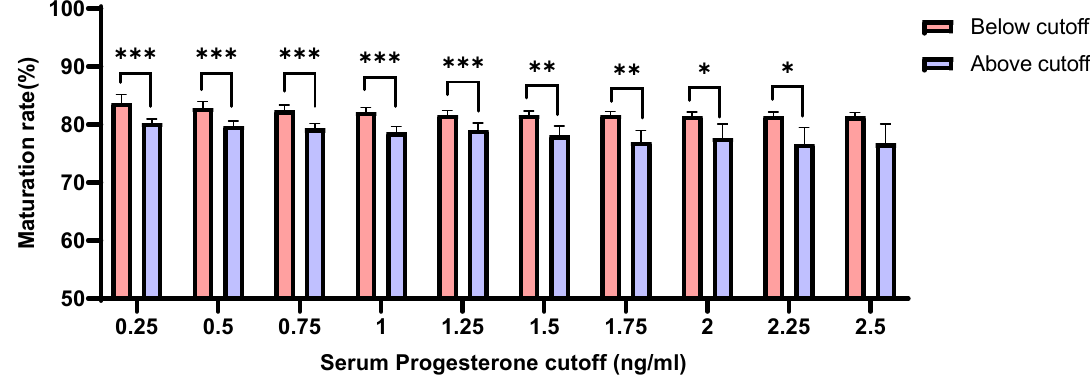
Figure 2. Association of the rates of oocyte maturation with the concentration of serum P4 levels (below or above each cut-off) on the day of hCG administration ( p < 0.05(*), p < 0.01(**), p < 0.001(***)). 3.4. The Effect of Serum Progesterone Levels on the Rate of Fertilization We evaluated the correlation between the levels of serum P4 on the day of hCG administration and the rates of fertilization. Interestingly, patients with serum P4 level ≥ 1.25 ng/mL showed noticeably lower rates of fertilization than those with P4 levels < 1.25 ng/mL ( p = 0.037) (Figure 3).